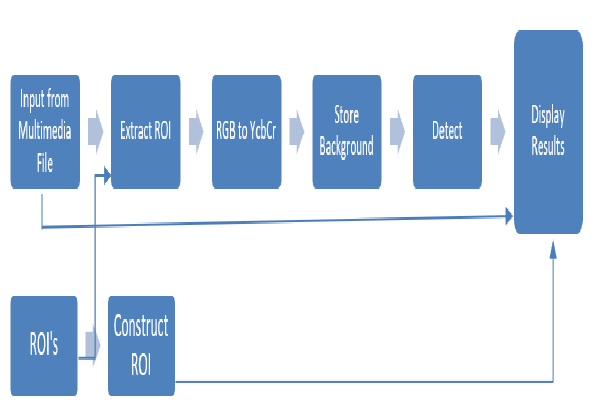
Figure 2. Block Diagram of the AOD